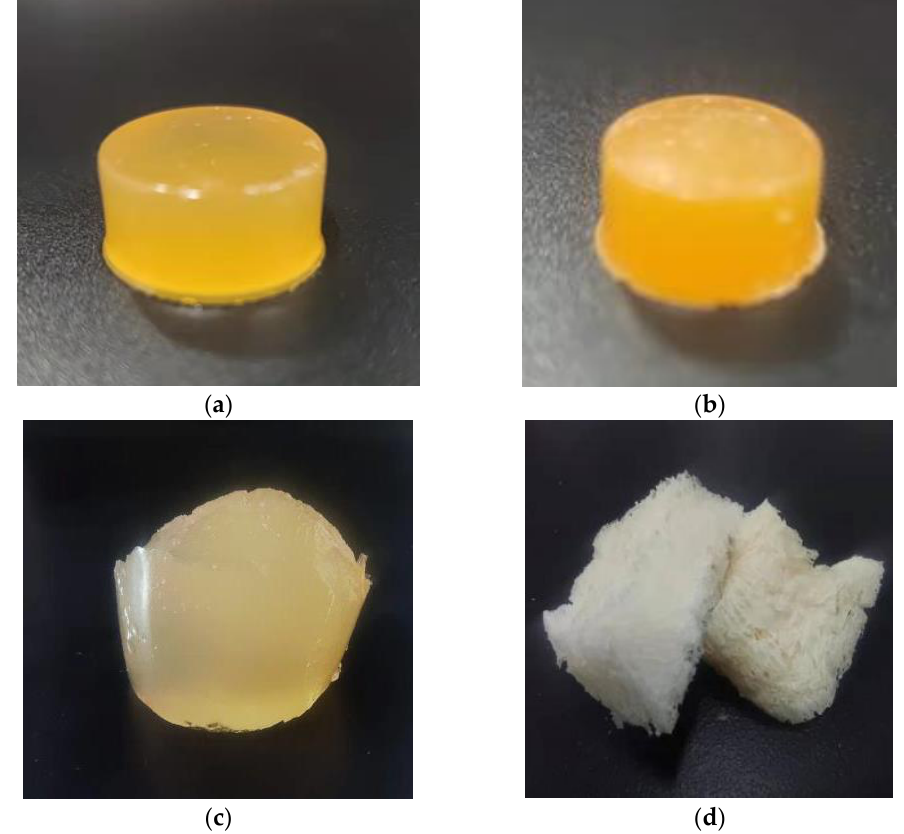
Figure 3. The photos of RIR/AA-co-AM hydrogel. Prepared RIR/AA-co-AM hydrogel ( a ); After ethanol dehydration ( b ); After soaking in DI water for 24 h ( c ); After freeze drying ( d ).